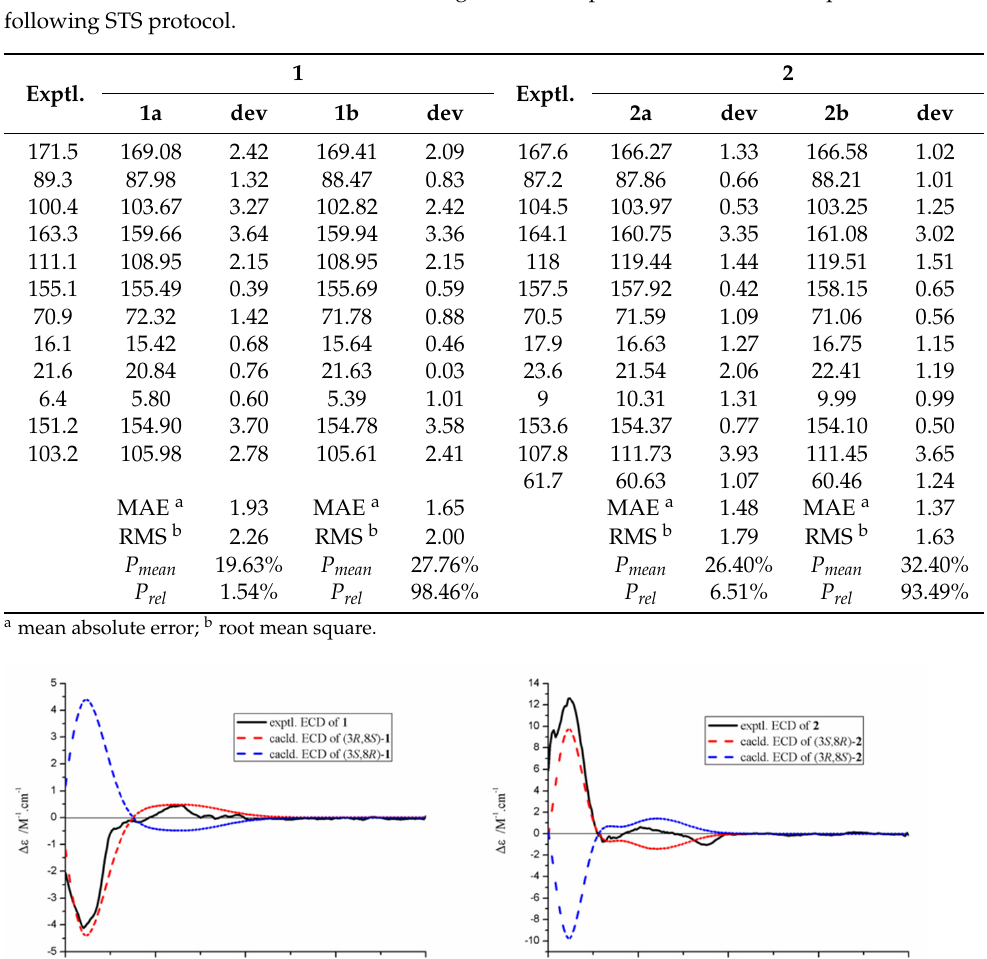
Table 2. Calculated 13 C chemical shifts fitting with the experimental data of compounds 1 and 2 following STS protocol.